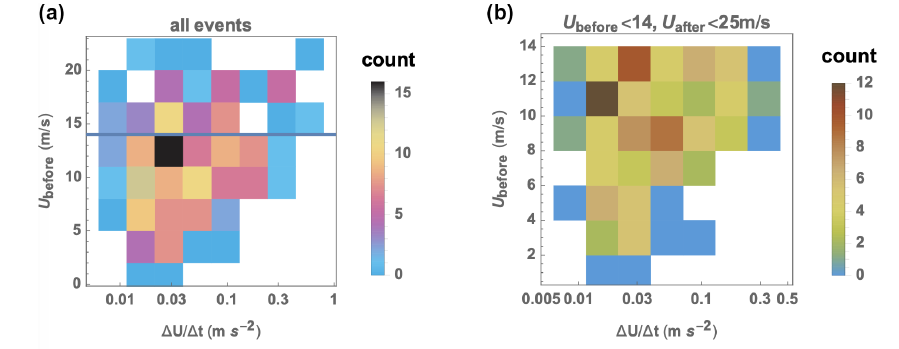
Figure 7. Distribution of accelerations per wind speed before ramp. (a) All events, where horizontal blue line shows lower limit of rejected events; (b) events considered here. Table 1. Ensemble of ramp events: parameters chosen.